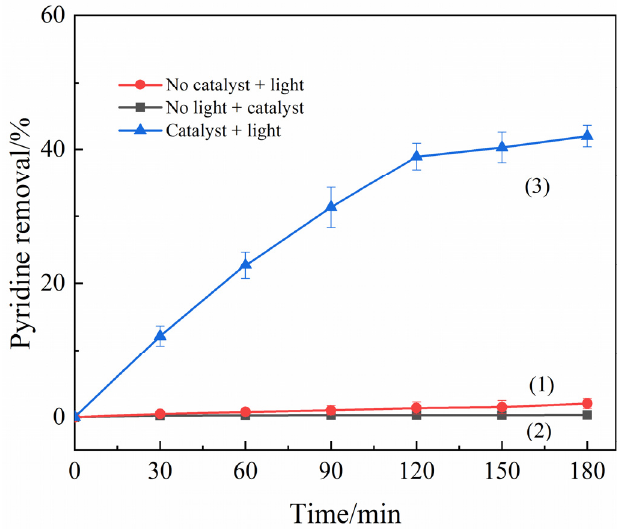
Figure 4. Photocatalytic blank test: (1) no catalyst, light intensity 560 W; (2) no light, photocatalyst dosage 150 mg/L; and (3) photocatalyst dosage 150 mg/L, light intensity 560 W.